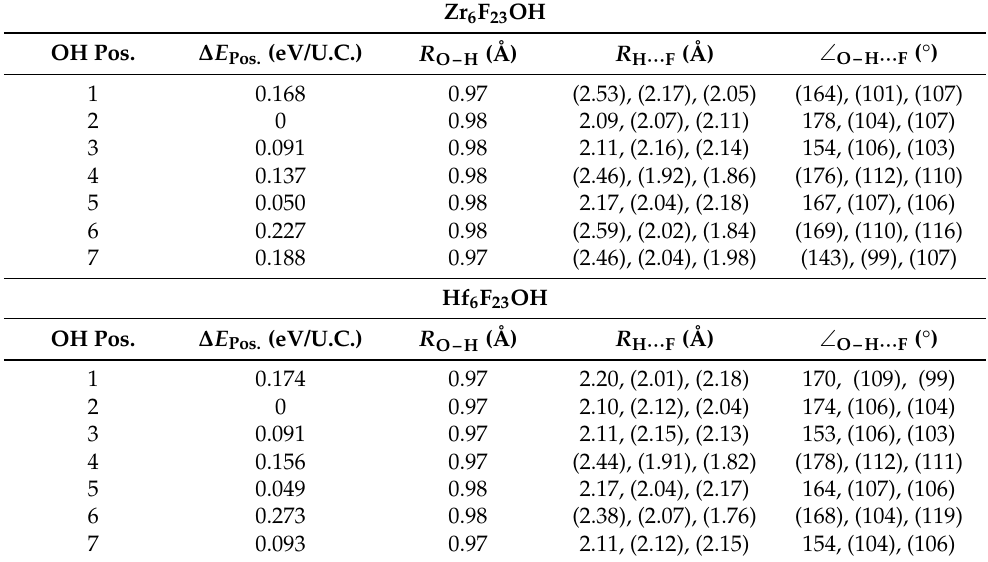
Table 5. Position of hydroxylation (OH Pos.), energy difference per unit cell (U.C.) between the positional isomers with respect to the most stable isomer ( ∆ E Pos. ), hydroxyl group bond length ( R O–H ), H-bond length ( R H ··· F ), and angle ( ∠ O–H ··· F ) within the mono-hydroxylated zirconium fluoride (top) or hafnium fluoride (bottom); H-bonds classified as weak by distance or angle are given in